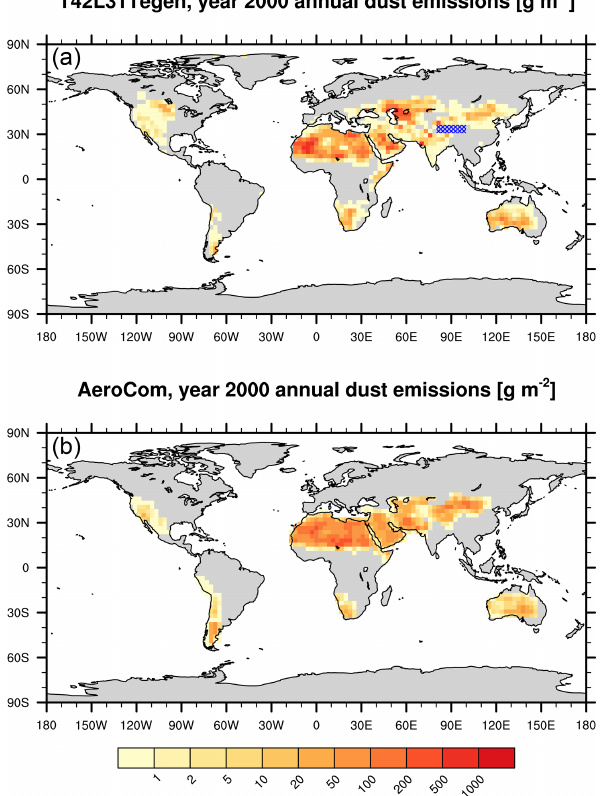
Figure 2. Global annual dust emissions in the (a) T42L31Tegen and (b) T42L31AeroCom setup. (a) Emissions were corrected for arte- facts in the Himalaya region and tuned according to AeroCom (for the region of 0–40 ◦ N, 20 ◦ W–50 ◦ E). Blue crosses correspond to excluded grid boxes due to setting t orogr to 4000m (12 of these 14 boxes would otherwise have emitted dust). The tuning results in a total dust emission of 1200Tga − 1 in the Sahara region and a total global dust emission of 2000Tga − 1 for the year 2000. (b) Aero- Com dust emissions were used for the T42L31AeroCom setup and as a reference for tuning online calculated Tegen et al. (2002) dust emissions. The total global AeroCom dust emission is 1700Tga − 1